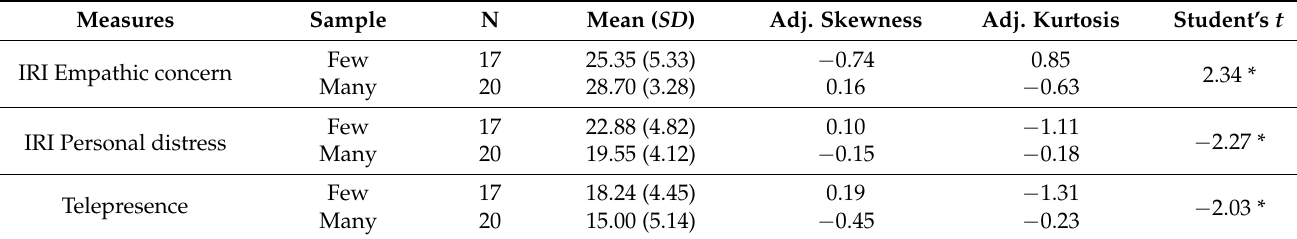
Table 7. Differences between receivers of higher vs. lower tingles in IRI and Telepresence Scale. Measures Sample N Mean ( SD ) Adj. Skewness Adj. Kurtosis Student’s t IRI Empathic concern